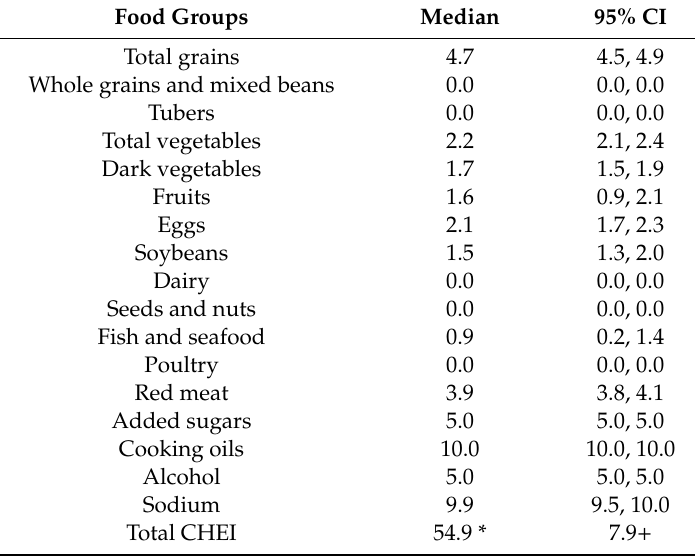
Table 3. CHEI components score among observed women.